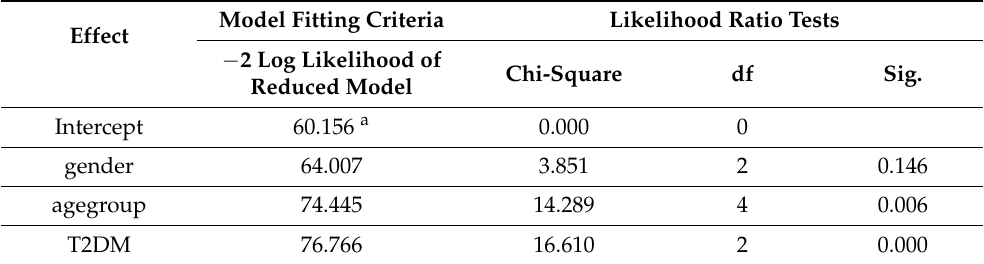
Table 7. Multinomial logistic regression analysis for the LEPR Gln223Arg genotypes. Likelihood Ratio